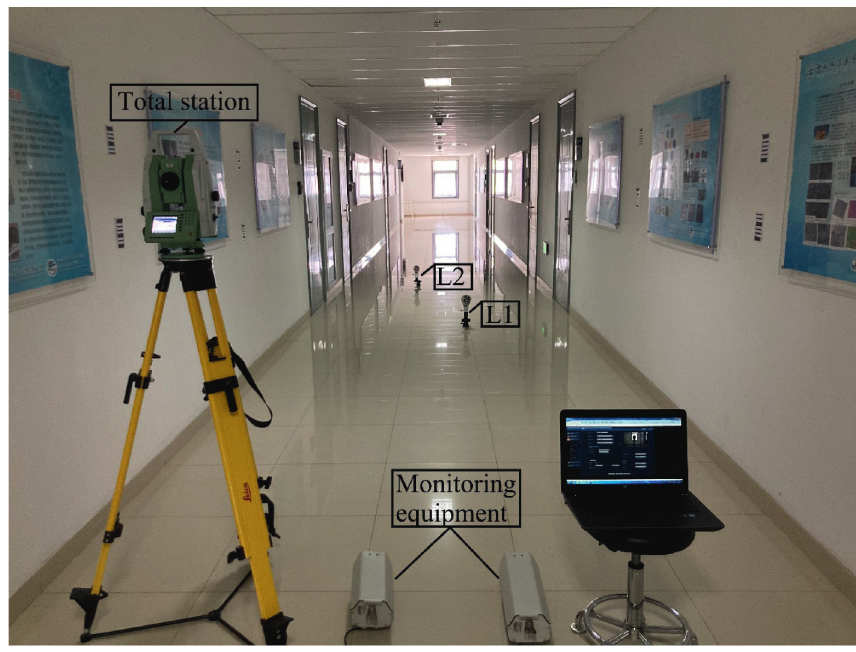
Figure 10: Deformation monitoring experiment.